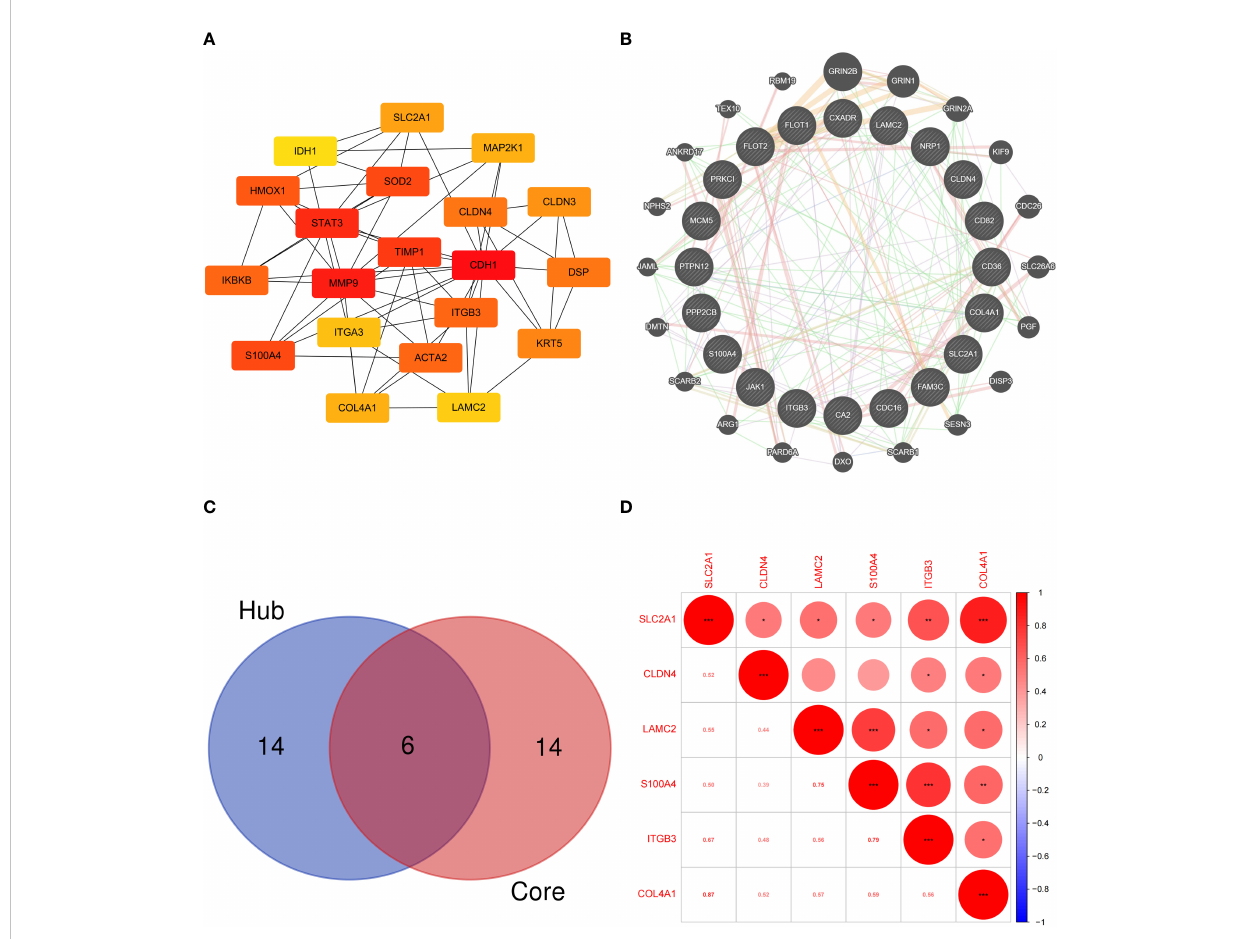
FIGURE 4 (A) Protein interaction network of hub EMT-related DEPs; (B) Interaction network of core EMT-related DEPs and related proteins in the GeneMANIA database; (C) Intersection of the hub EMT-related DEPs and core EMT-related DEPs; (D) Correlation analysis of key EMT-related DEPs expression in